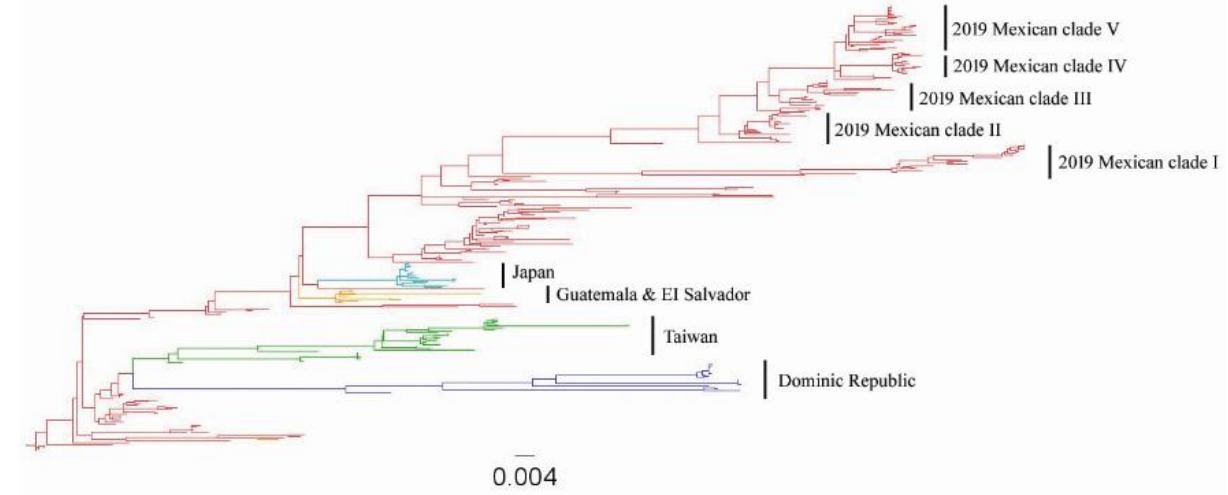
Figure 4. ML phylogenetic tree of the H5 HA genes of 284 Mexican lineage H5N2 AIVs collected between 1994 and 2019. Phylogenies are colored by the origin of the country. Red, Mexico; blue, Dominic Republic; green, Taiwan; yellow, Guatemala and EI Salvador; cyan, Japan. Distinct clades in 2019 Mexican H5N2 AIVs are denoted as clades I to V.